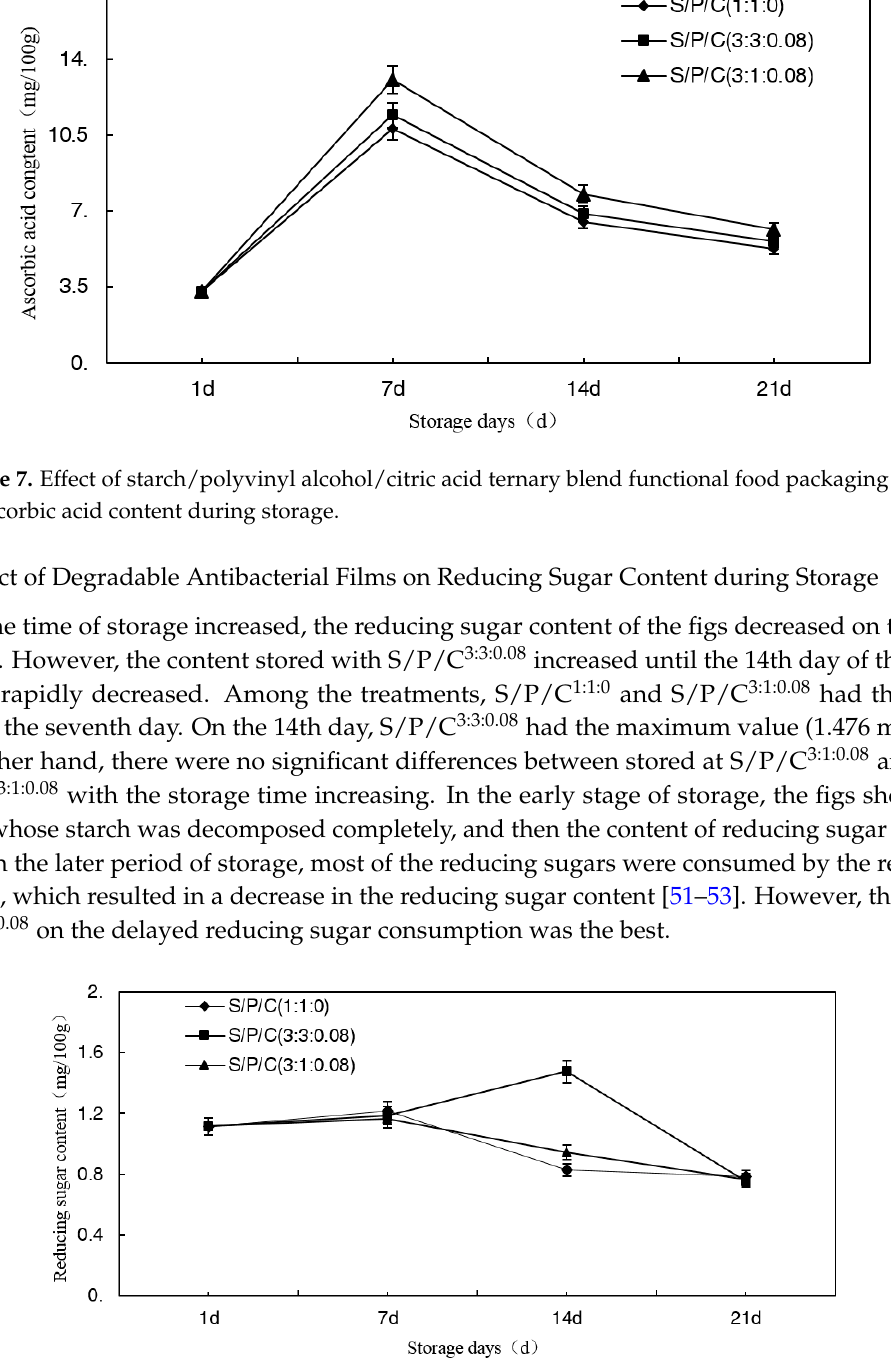
Figure 8. Effect of starch/polyvinyl alcohol/citric acid ternary blend functional food packaging films antibacterial and degradable film on reducing sugar.